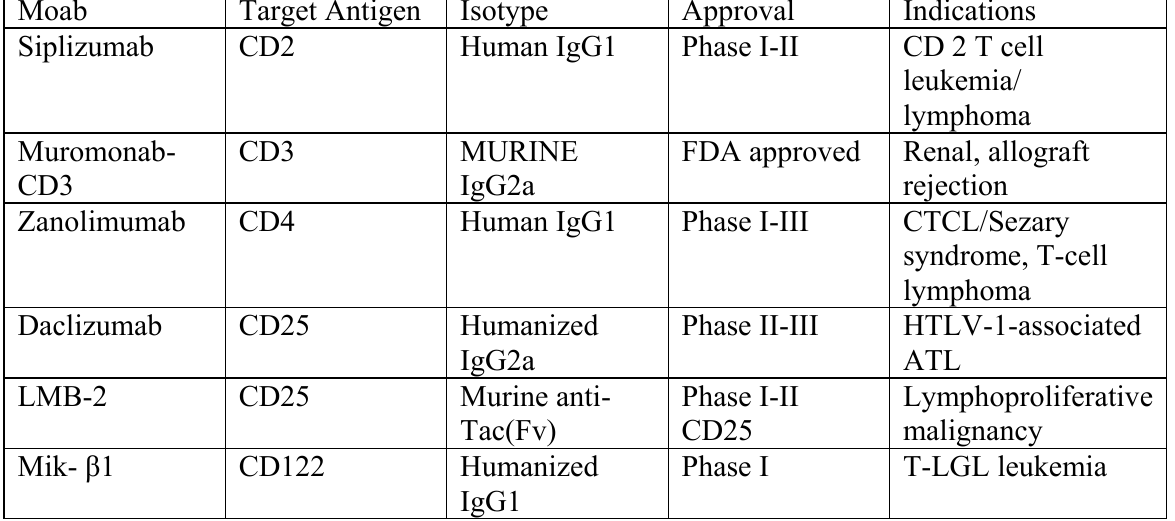
Table 3. Monoclonal antibodies for treatment of T call lymphoma